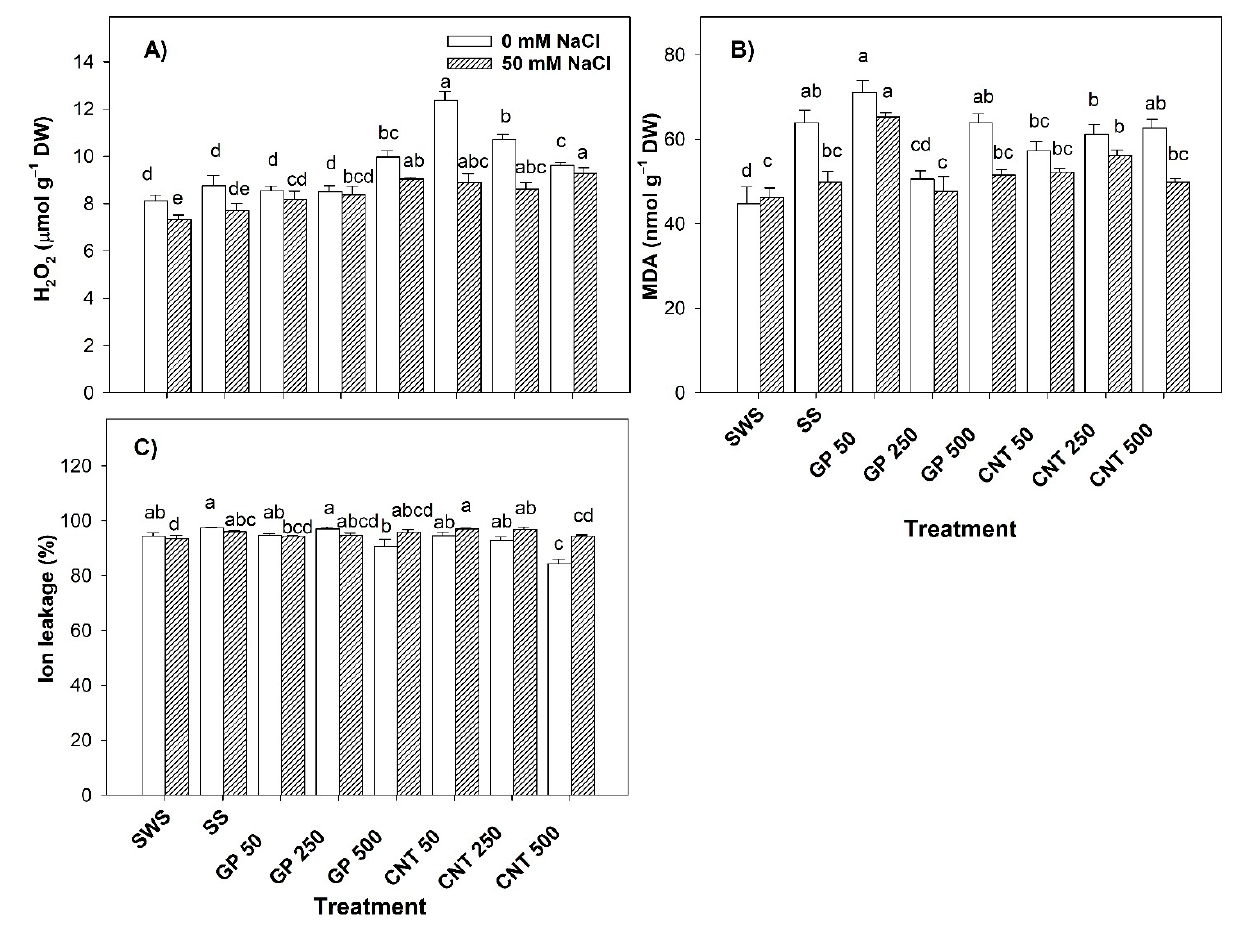
Figure 2. Stress markers in tomato plant leaves treated with carbon nanomaterials and salinity: ( A ) hydrogen peroxide (H 2 O 2 ), ( B ) malondialdehyde (MDA), and ( C ) ion leakage. DW: dry weight; SWS: non-sonicated seeds; SS: sonicated seeds; GP: graphene; CNT: carbon nanotubes; 50, 250, and 500 represent the mg L − 1 applied of carbon nanomaterial. Different letters indicate a significant difference between treatments according to Fisher ( α = 0.05). n = 6 ± standard error.